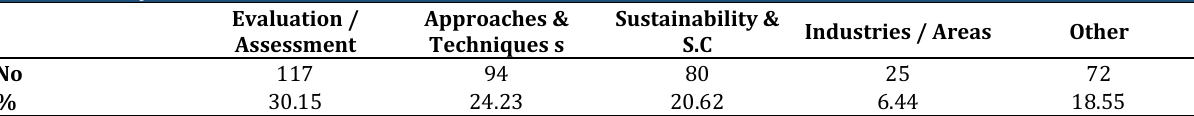
Table 7: Keyword classes